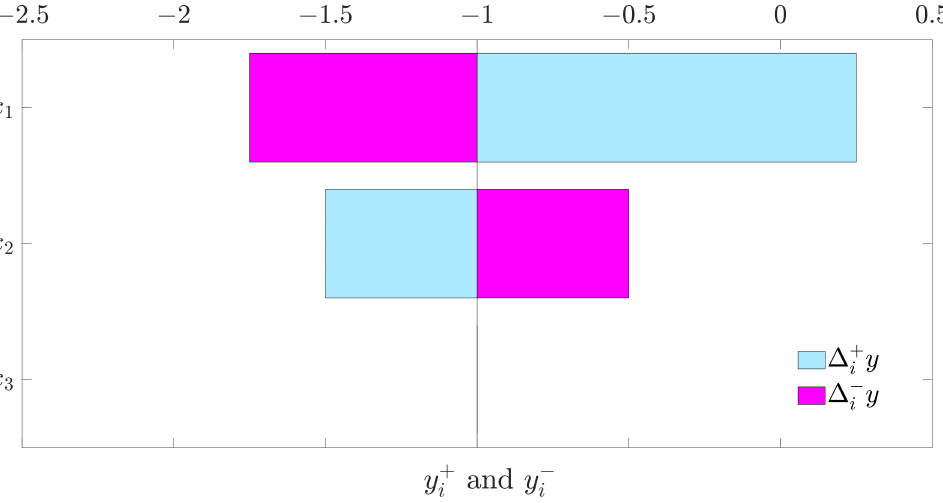
y , i.e., the effect of shifting the model inputs, i